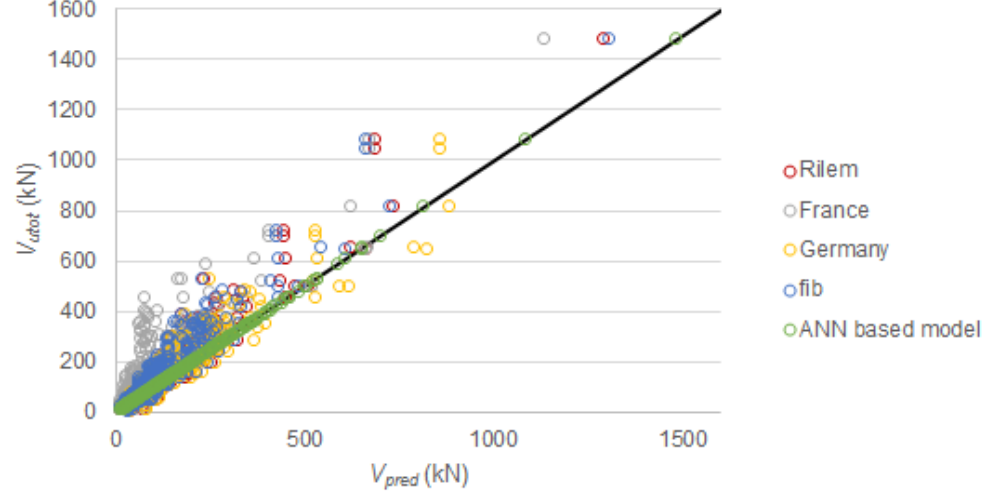
Figure 9. Comparison between ANN-based model and currently available code predictions. Table 8. Statistical properties of V utot / V pred for all datapoints, with AVG = average of V utot / V pred , STD = standard deviation on V utot / V pred , and COV = coefficient of variation of V utot / V pred . This table repeats results from [114] for comparison to our proposed model. Model